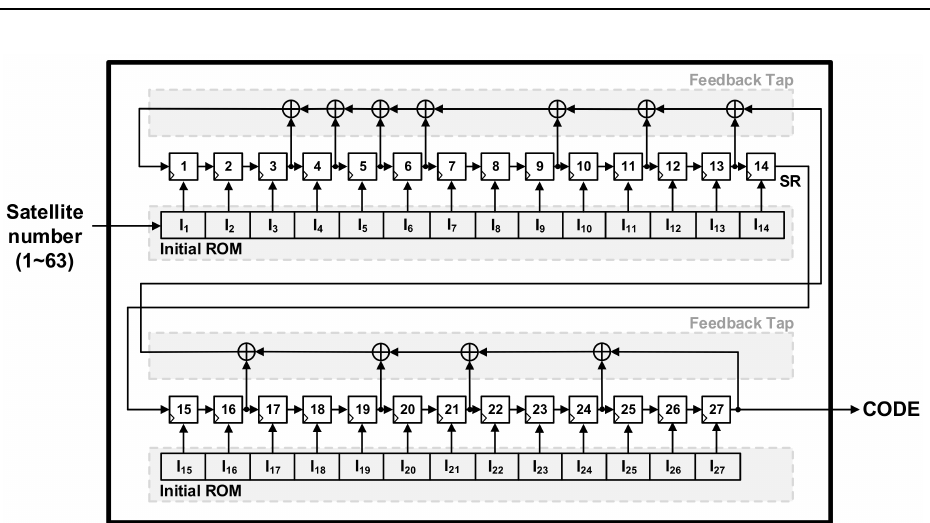
Figure 1. Conventional code generator architecture of GPS L2C signal